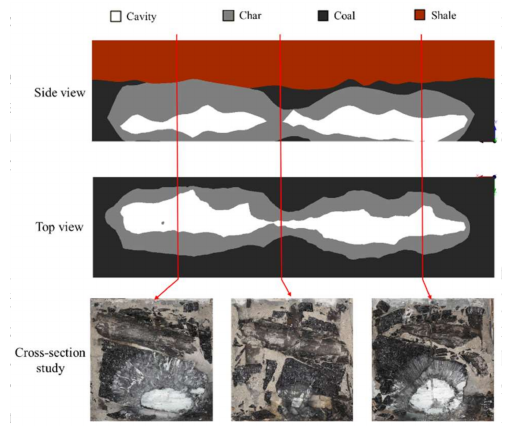
Figure 9. Estimation of post-gasification